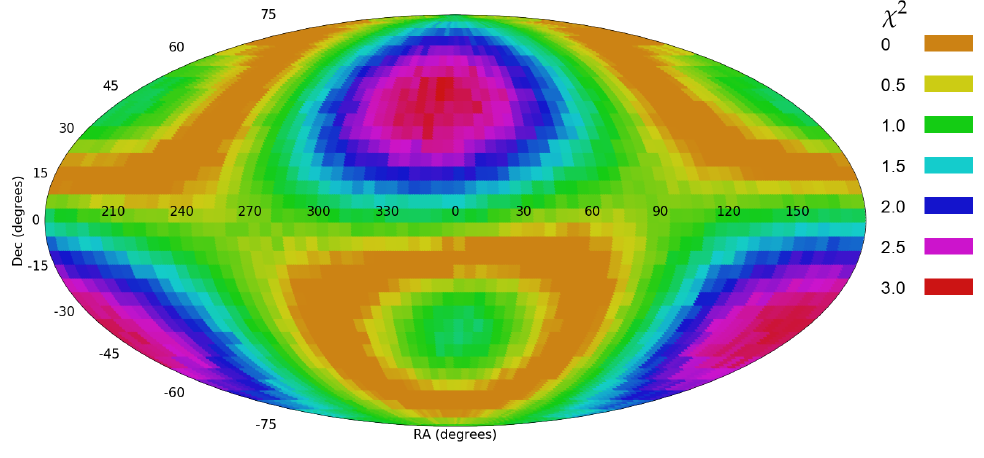
Figure 6. The probability of a quatdrupole axis from different ( α , δ )